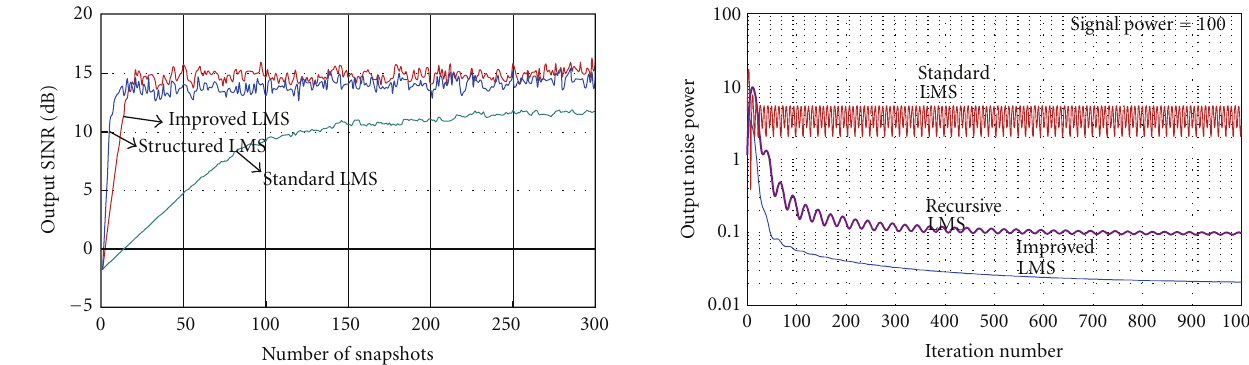
Figure 2: Learning curve of DF-GSC scheme of adaptive array using di ff erent LMS algorithms.